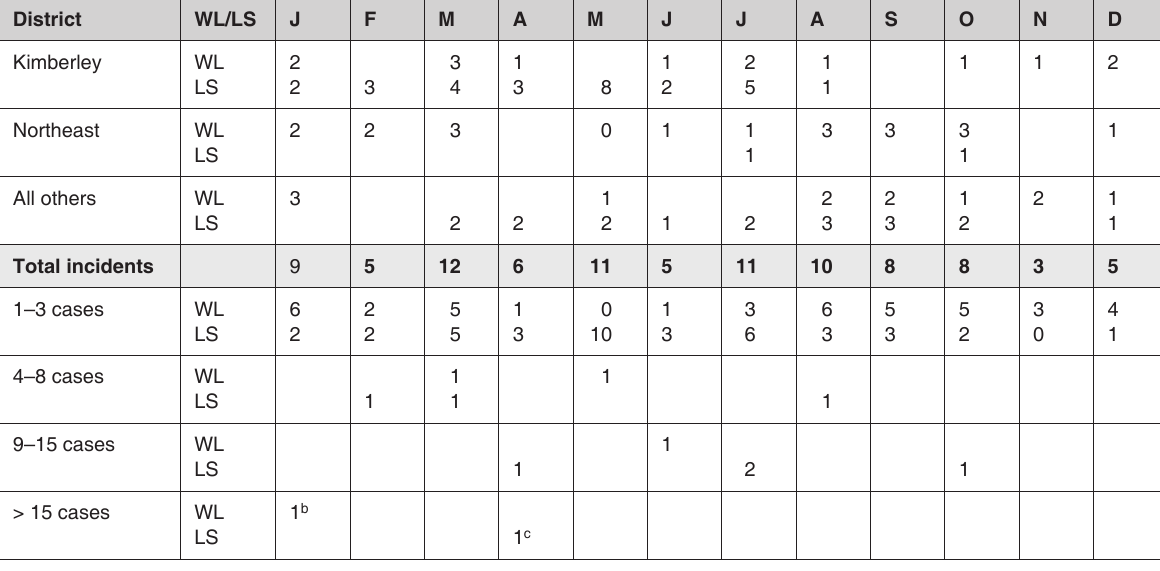
TABLE 1 Reported incidents of anthrax in wildlife (WL) and livestock (LS) in South Africa, 1995–2005, by month, district and numbers of cases a